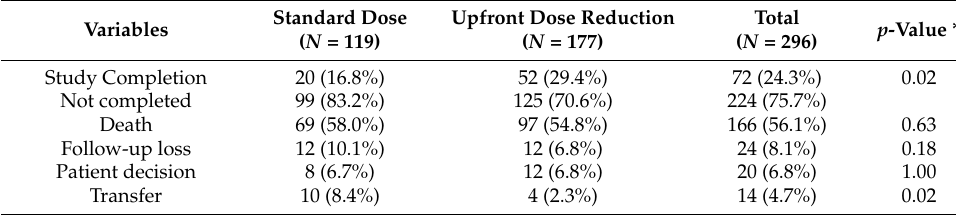
Table 7. The completion of first-line palliative chemotherapy as